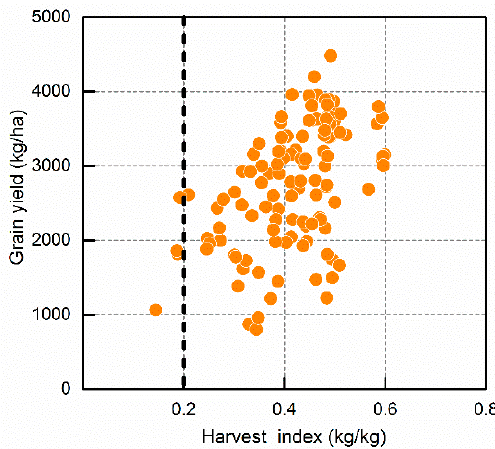
Figure 2. Relationship between grain yield and harvest index for soybean. The black line was used to exclude the value of HI < 0.2.